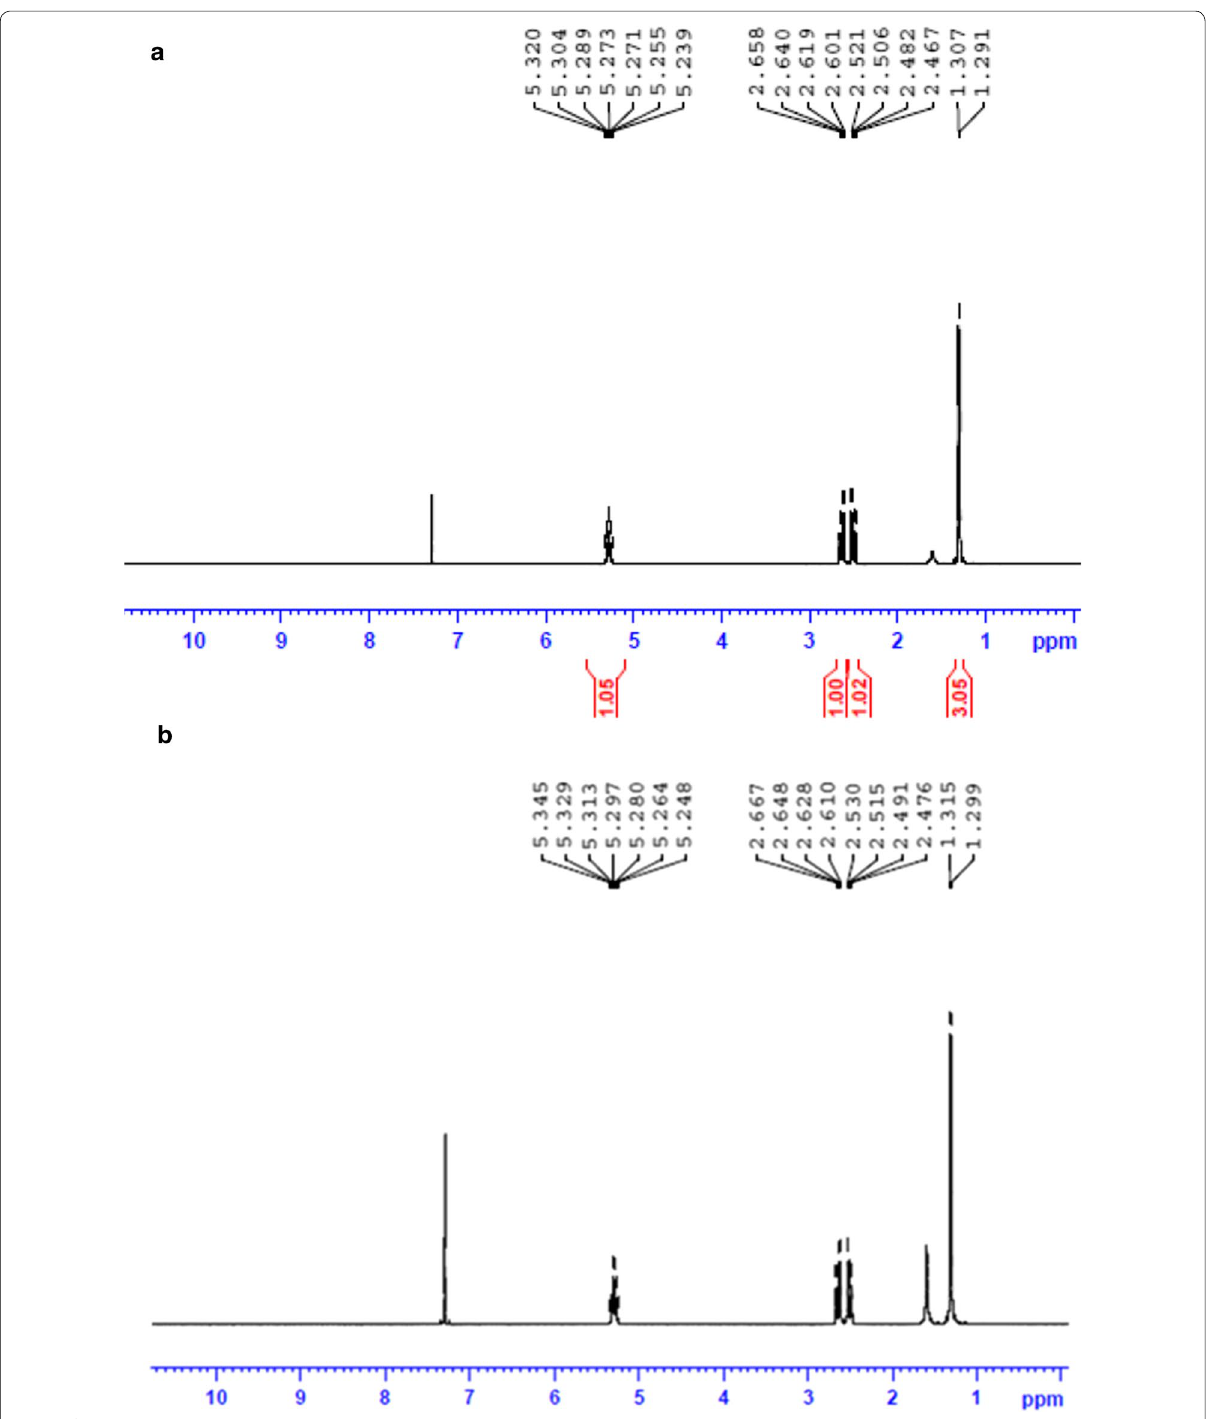
Fig. 4 1 H NMR spectra of the polymer suspended in CDCl 3 . a PHB standard (Sigma), b PHB from the recombinant